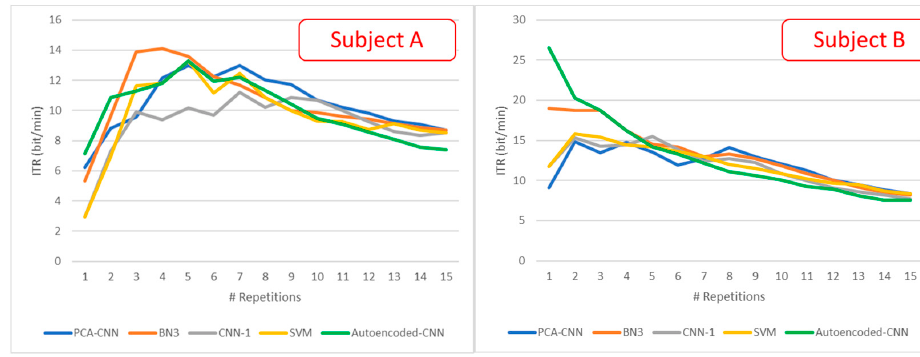
Figure 8. ITR graph for four algorithms on Dataset 2.